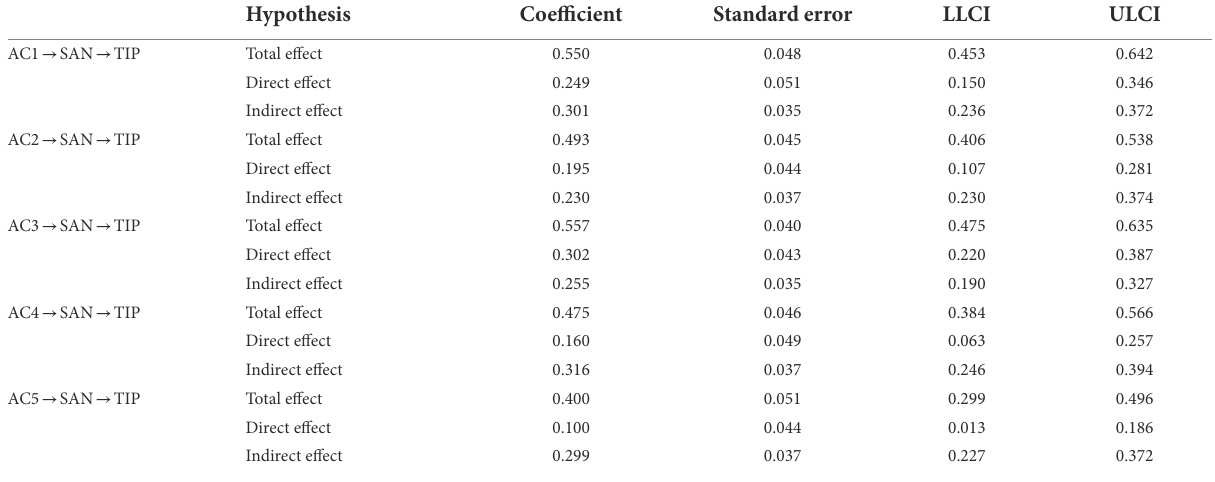
TABLE 6 Bootstrap mediation effect test